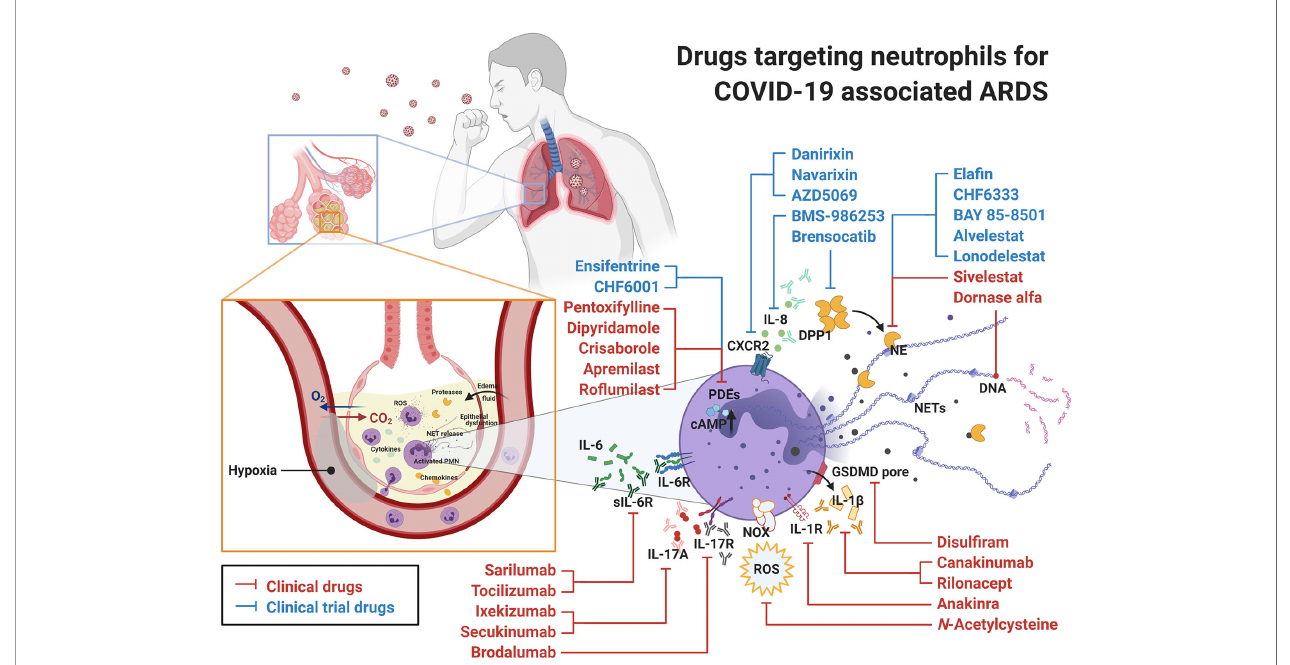
FIGURE 2 | Drugs targeting neutrophils for COVID-19 associated ARDS. Clinical drugs (in red) and clinical trial drugs (in blue) are displayed with their targets in neutrophils. In COVID-19 infection, the release of SARS-CoV-2 RNA in lungs serves as PAMP and induces complicated immune reactions leading to ARDS and respiratory failure. Under these circumstances, neutrophils recruited to the site of infection participate in the elimination of SARS-CoV-2, but they also contribute to the pathogenesis of ARDS. Therefore, the commercial drugs targeting neutrophils might be considered as novel candidates to treat COVID-19 associated ARDS. ARDS, acute respiratory distress syndrome; CXCR, C-X-C chemokine receptor; DPP1, dipeptidyl peptidase 1; GSDMD, gasdermin D; IL, interleukin; NE, neutrophil elastase; NET, neutrophil extracellular trap; NOX, NADPH oxidase; PDE, phosphodiesterase; PMN, polymorphonuclear leukocyte; ROS, reactive oxygen